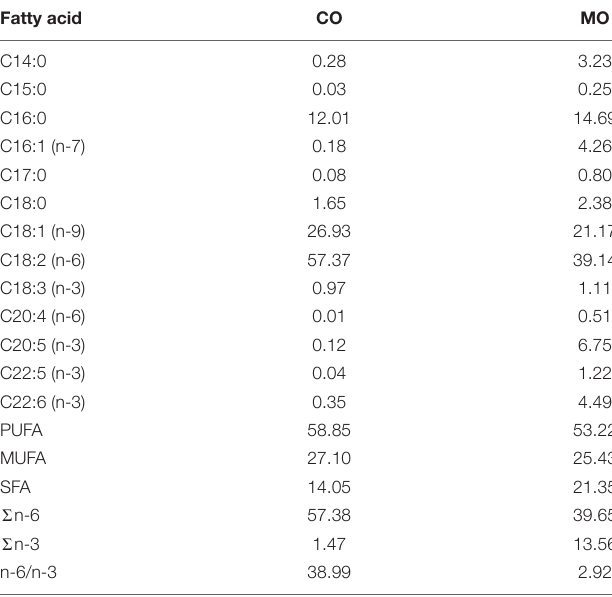
TABLE 2 | Fatty acid composition of corn oil- (“CO”) and menhaden oil- (“MO”) enriched diets as fed to garden dormice for at least 3 weeks during their pre-hibernation fattening